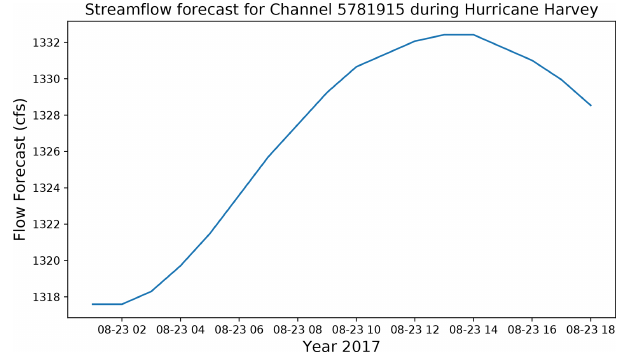
Figure 9. Time series plot for the accessed NWM streamflow